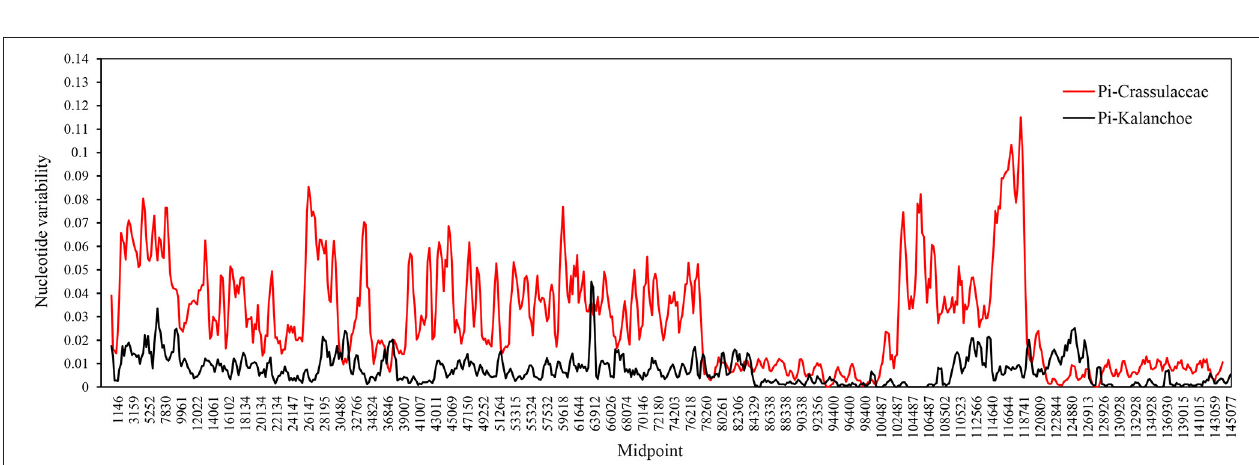
FIGURE 5 | Sliding window analysis between the Kalanchoe plastome (black line) and the family Crassulaceae plastome (red line). Window size: 600 bp, step size: 200 bp. X -axis: the position of the midpoint of a window (kb). Y -axis: nucleotide diversity of each window.